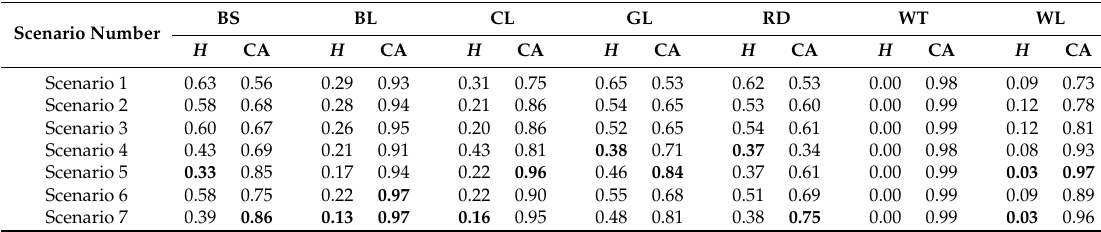
Table 8. The values of median uncertainty ( H ) and class-specific accuracies (CA) for each of the land cover classes achieved by different input feature scenarios. The values of minimum median uncertainty and maximum class-specific accuracies are in